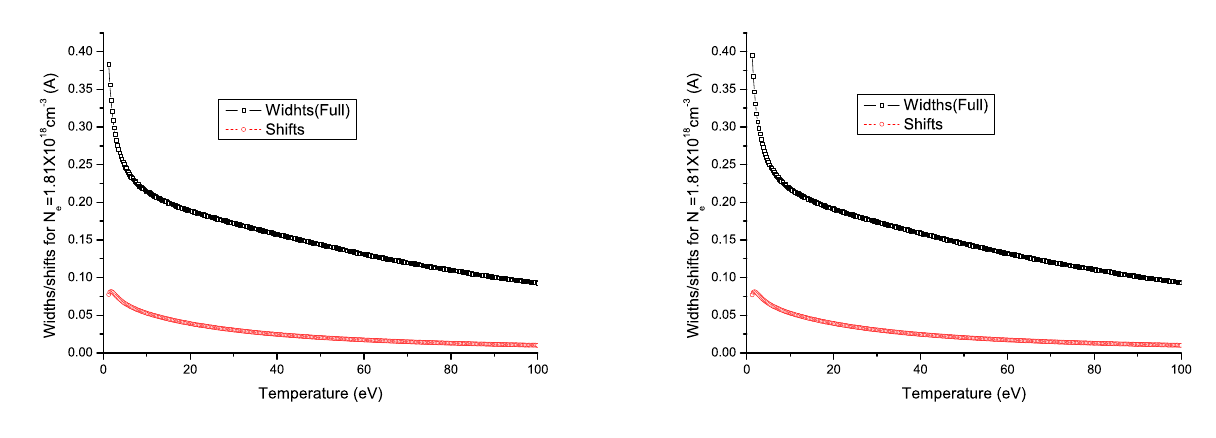
Figure 1. The electron-impact widths (FWHM) and shifts of doublet transitions ( 2 p ! 2 s ) in B III ions as a function of electron temperature for an electron density of 1 : 81 (cid:2) 10 18 cm (cid:0) 3